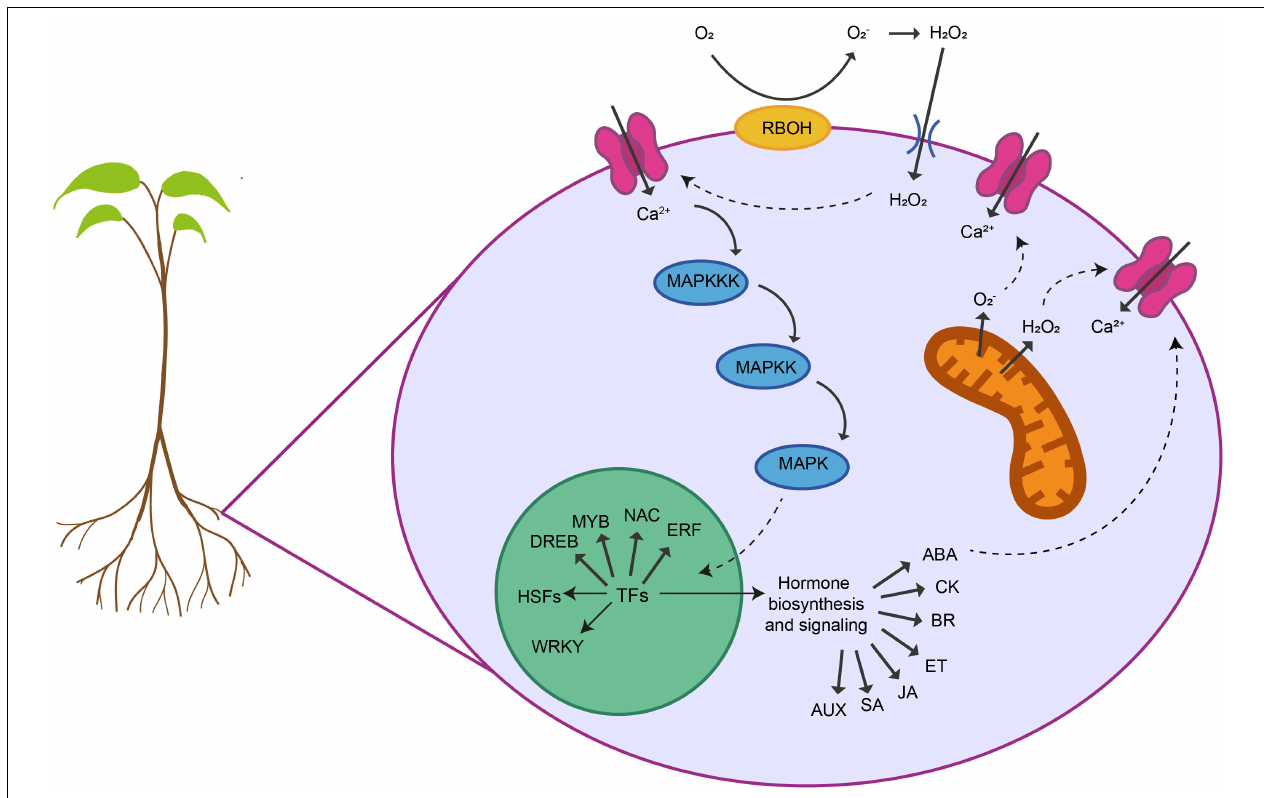
FIGURE 1 | Shared responses of plant roots to abiotic stresses. Roots display different cellular and molecular responses to alleviate the negative effects in their development and functionality provoked by abiotic stresses. Several key sensing, signaling and regulatory networks are shared between different stresses. First, roots are able to sense the stress and activate several physiological adaptive processes. Many abiotic stresses provoke a damage of the membranes and the loss of ionic and osmotic homeostasis that triggers ROS (O 2 − , H 2 O 2 ) accumulation within different organelles. ROS is produced at the plasma membrane or the mitochondria by NADPH oxidases (RBOHs). This ROS has a dual function in response to abiotic stresses. Although at high levels, ROS are toxic to the cells, they can also act as a signal transducer activating Ca 2 + channels that causes an increase in the intracellular Ca 2 + concentration. This flux of Ca 2 + triggers a cascade of events that activates calcium-dependent protein kinases (MAPKs) that phosphorylate and activate different TFs in the nucleus. These TFs belong to different families including, DREBs, MYBs, NAC, ERFs, WRKY, and HSFs. These TFs can regulate the expression of downstream genes involved in specific gene regulatory networks modulating each abiotic stress. They also regulate the biosynthesis and the metabolism of different phytohormones that in turn coordinate various signal transduction pathways regulating abiotic-stress response. On the other hand, interplay between ROS and hormone signaling orchestrates the acclimation response of plants to different abiotic stress